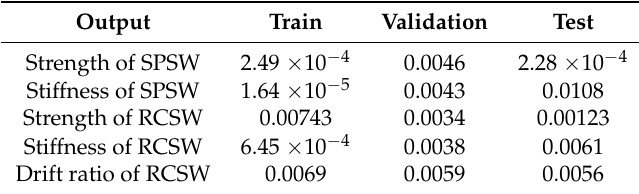
Figure 5. Regression values for the proposed ANN meta-model. ( a ) SPSW; Strength, ( b ) SPSW; Stiffness, ( c ) RCSW; Strength, ( d ) RCSW; Stiffness, ( e ) RCSW; Drift ratio. Table 5. MSE values for training, validation and test